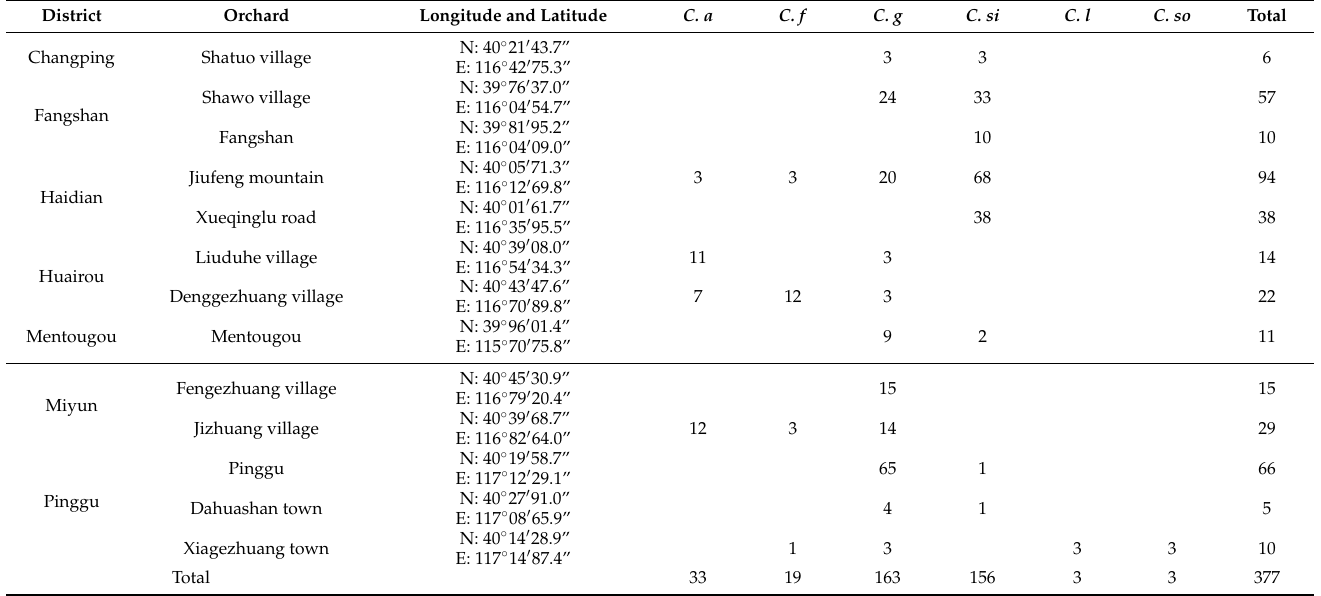
from the Pinggu district (Table 3). In terms of plant tissues, 82 strains consisting of two species, C. gloeosporioides and C. siamense , were isolated from walnut fruits, whereas the other 295 strains, consisting of six species, were isolated from walnut leaves. Table 3. Regional diversity of Colletotrichum spp. of walnut anthracnose in Beijing.